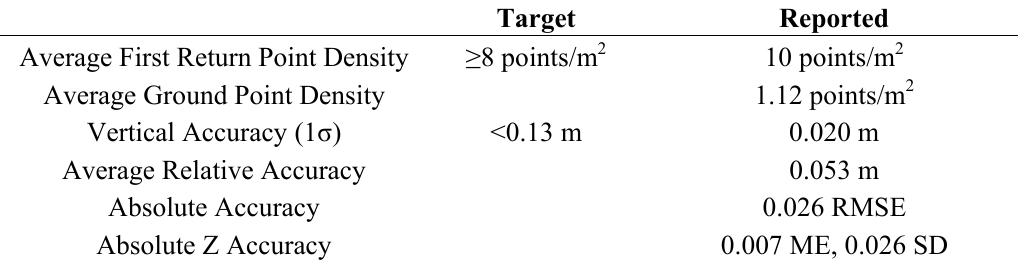
Table 3. Laser point density and accuracy reported by